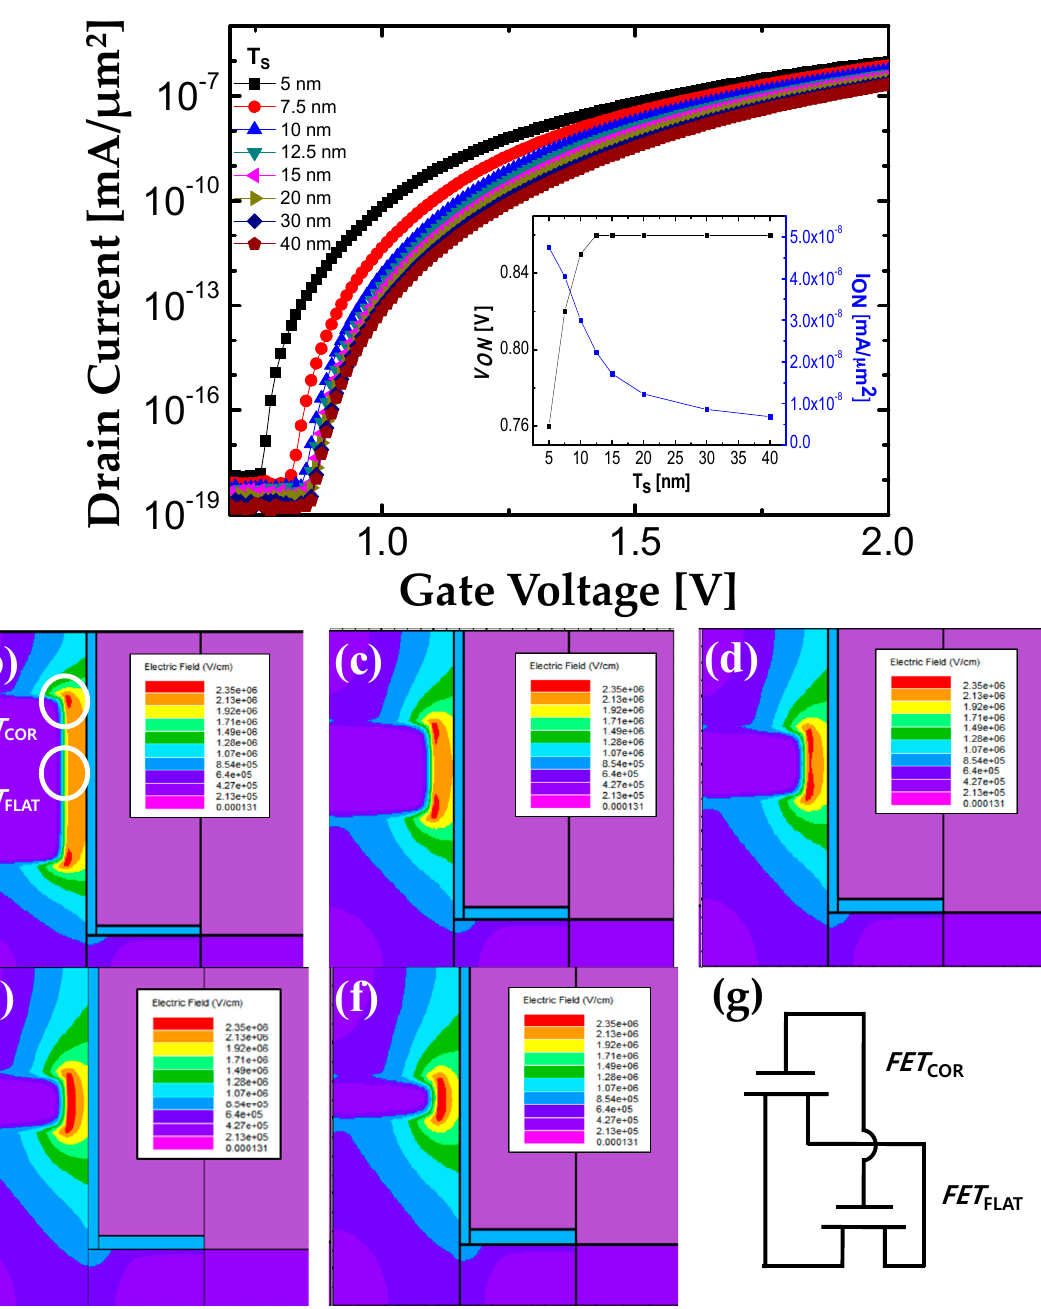
Figure 3. ( a ) Normalized log scale transfer characteristics with various T S at V DS = 0.7 V. The inset figure shows V ON and normalized on-state current ( I ON ) which is defined as I D at V GS = 0.5 + V ON divided by T S . Electric field contour plots for ( b ) T S = 40 nm, ( c ) T S = 15 nm, ( d ) T S = 10 nm, ( e ) T S = 7.5 nm, and ( f ) T S = 5 nm. These plots are extracted at V DS = 0.7 V and V GS = 0.86 V which is corresponded to the V ON of T S = 40 nm. ( g ) Schematic circuit model for F-shaped TFET.